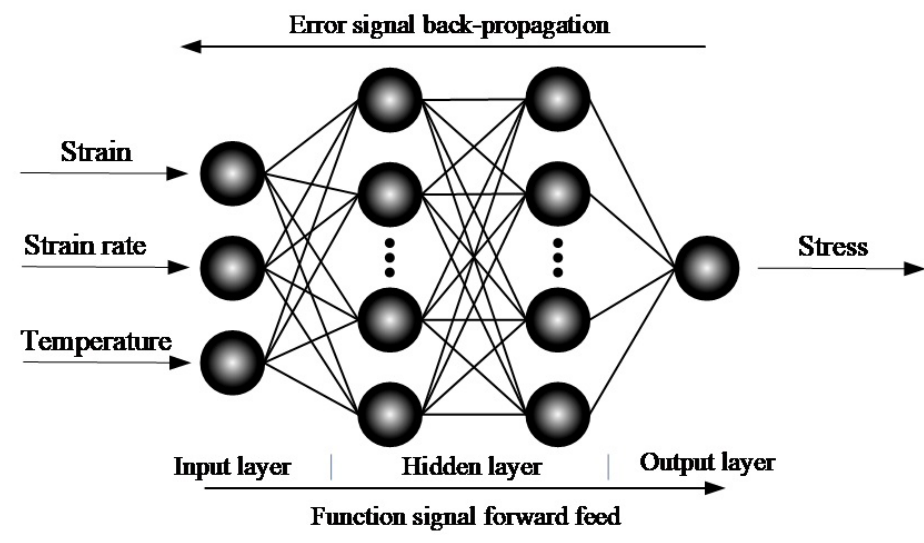
Figure 2. Schematic illustration of the neural network